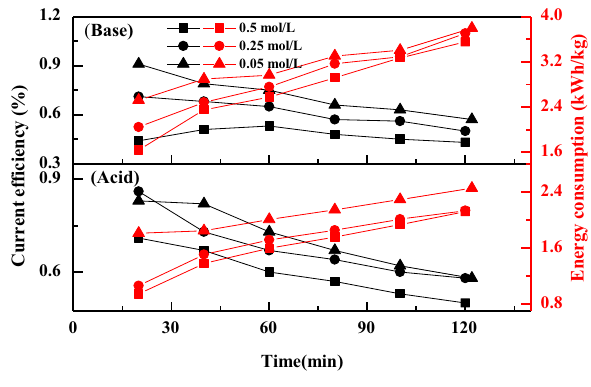
Fig. 8 The efficiency ( ƞ ) and energy consumption (EC) of HCl and LiOH at different initial concentration